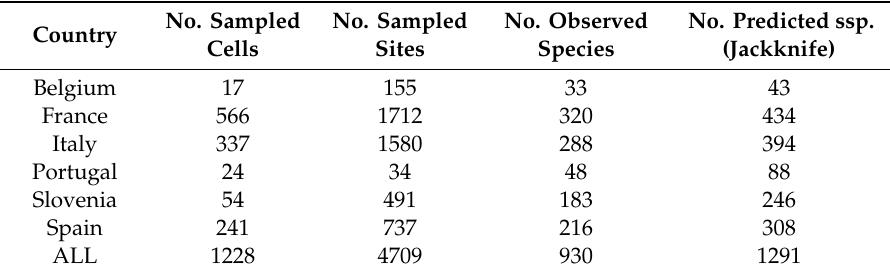
Table 2. Groundwater biodiversity in six European countries—from Deharveng et al. [49], modified. No. Sampled No. Sampled No. Observed No. Predicted ssp. Country Cells Sites Species (Jackknife) Belgium 17 155 33 43 France 566 1712 320 434 Italy 337 1580 288 394 Portugal 24 34 48 88 Slovenia 54 491 183 246 Spain 241 737 216 308 ALL 1228 4709 930